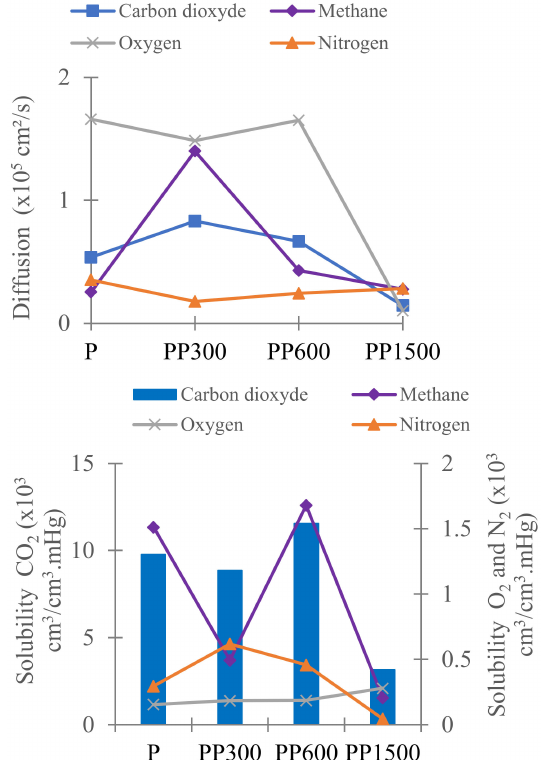
Figure 4. Solubility and diffusion coefficients of CO 2 , CH 4 , N 2 , and O 2 of neat Pebax and Pe- bax/PEG